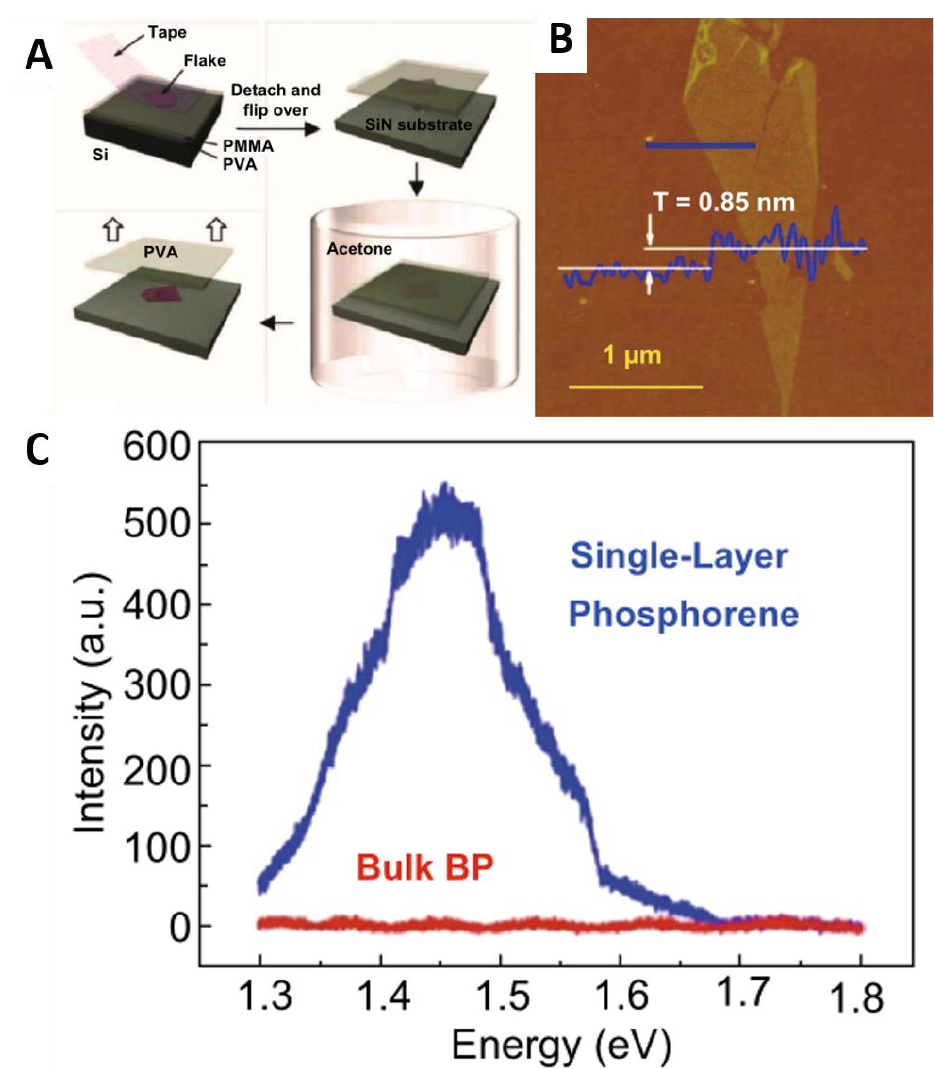
Figure 1. ( A ) Process of preparation of less layer BP by mechanical stripping [31]. ( B ) AFM image